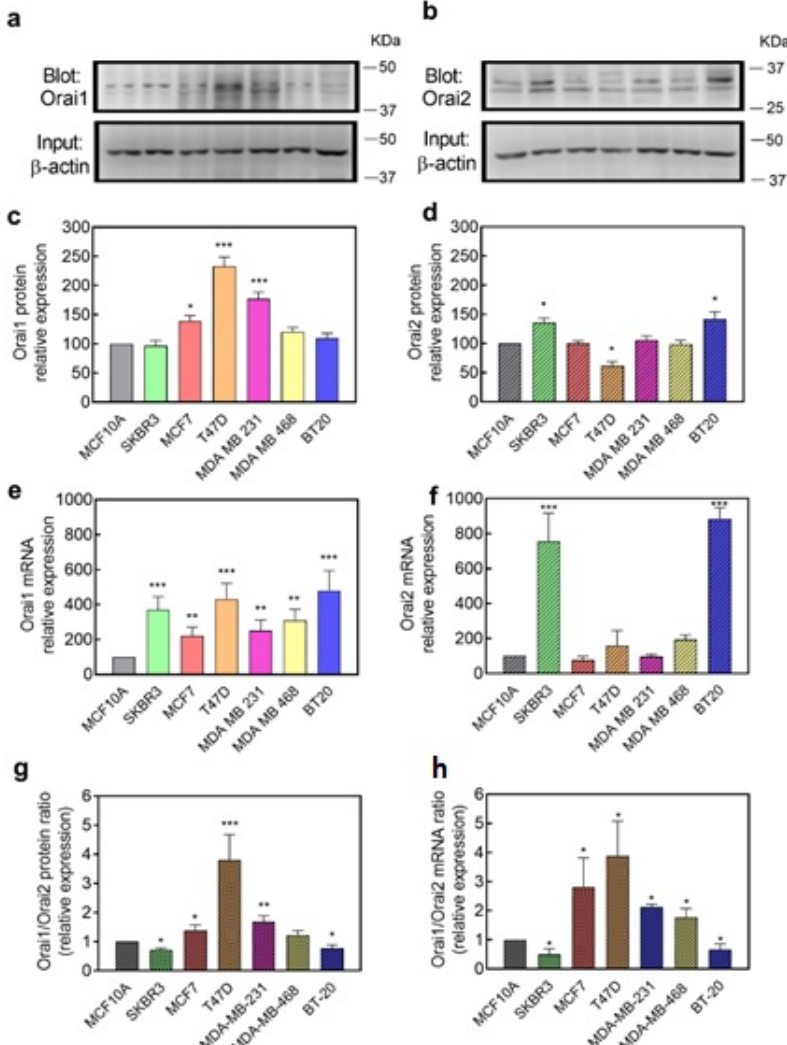
Figure 1. Orai1 and Orai2 mRNA and protein expression in breast cancer cell lines. Cells from the non-tumoral MCF10A cell line, as well as the HER2+ SKBR3, ER+ MCF7 and T47D and triple negative MDA-MB-231, MDA-MB-468 and BT20 breast cancer cells lines were lysed, and 50 µ g of proteins each were loaded in the same gels. Whole cell lysates were subjected to 10% SDS-PAGE and